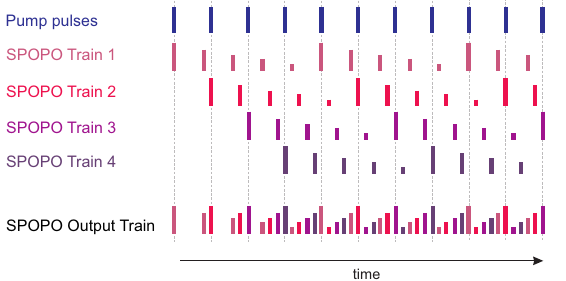
Figure 10. The principle of the pulse multiplication, factor of multiplication n = 5.